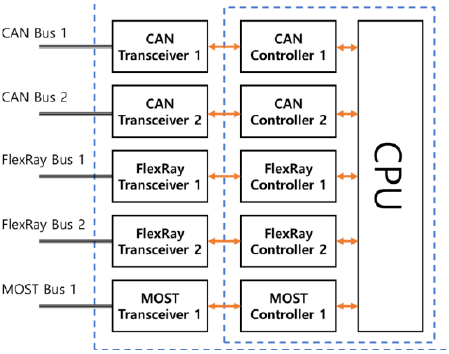
Figure 5. The hardware structure of the MIGM.